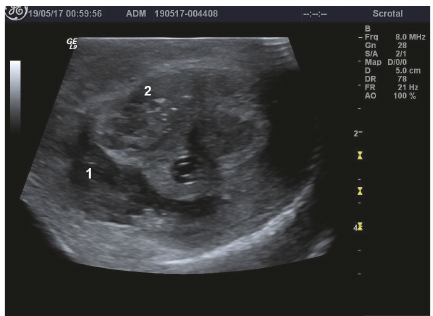
Figure 2: Preoperative ultrasonography of the penile shaft demon- strating hyperechogenic fluid collection with gas at the middle of the penileshaft,incontactwiththerightcorpuscavernosumandcorpus spongiosum (1) and gas in the right corpus cavernosum (2).